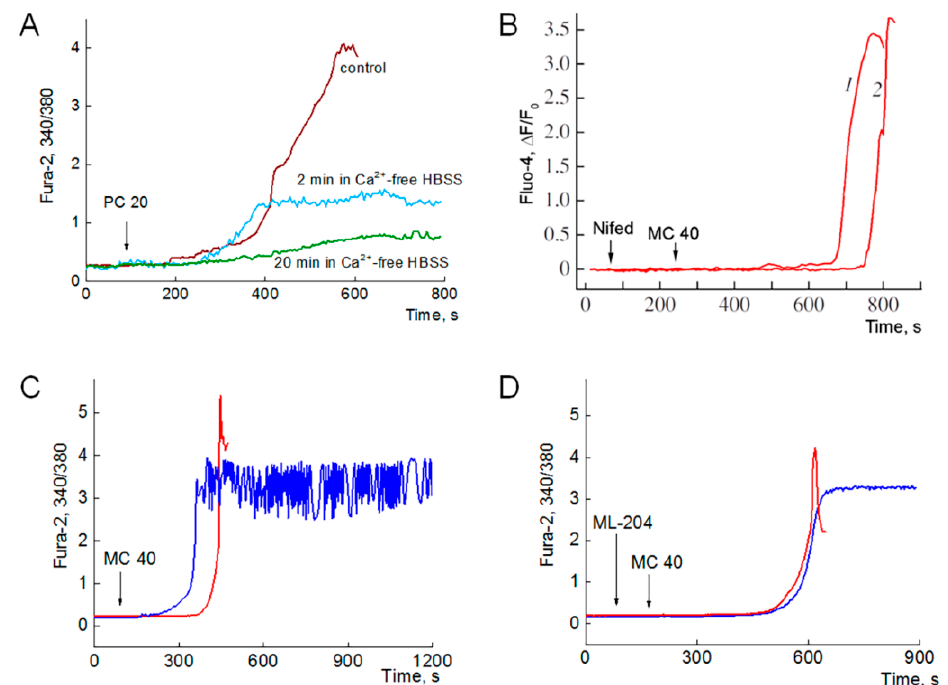
Figure 2. Ca 2 + -overload does not depend on external Ca 2 + influx. E ff ects of Ca 2 + -free medium and blockers of LCC and TRPC. ( A ). E ff ect of extracellular Ca 2 + on the increment of [Ca 2 + ] i (registered as Fura-2 340 / 380 ratio) induced by 20 µ M PC. Here, representative control and typical Ca 2 + traces are depicted. Cardiomyocytes were exposed to Ca 2 + -free medium for 2 min (red trace) and 20 min (green trace), while brown trace depicts control experiment with 1.3 mM Ca 2 + in extracellular medium. Hypercontracture and cell death were registered for control cells ( n = 6) and cells exposed to Ca 2 + -free medium (HBSS) for 2 min ( n = 8). Cells exposed to Ca 2+ -free medium for 20 min were viable after PC load ( n = 6). ( B ). L-type calcium channels do not significantly contribute to Ca 2+ overload. Average values of [Ca 2+ ] i (as Fluo-4 Δ F/F 0 ) are depicted in pane B for all cells ( n = 6 and 8). Preincubation of cardiomyocytes with 1 µ M nifedipine, a blocker of LCC, did not significantly a ff ected the values of such parameters as lag period, slope, and peak [Ca 2 + ] i characterizing Ca 2 + overload compared to control (traces 1 vs. 2). Ca 2 + overload, hypercontracture and CM death were induced by 40 µ M MC. This panel was adapted from [25] with permission. Viability score (VS), that is the ratio of viable to total cells in the plate, is indicated by corresponding values in panels ( C , D ). The e ff ect of TRPC blocker ML-204 (10 µ M) on Ca 2 + overload and Ca 2 + oscillations evoked by 40 µ M MC. Here, representative control ( C ) and typical Ca 2 + traces registered in presence of ML-204 ( D ) are depicted. In the control 40 µ M MC evoked Ca 2 + overload, hypercontracture and death within 300–350 s in 7 of 9 cells (representative red trace). In 2 cells MC triggered fast Ca 2 + oscillations lasting over 30 min (dark blue trace).Thus, for the control experiment, VS = 2 / 9 ( n = 9). Preincubation of CM with 10 µ M ML-204, a potent TRPC blocker, did not have any significant e ff ect on the values of lag period, slope and amplitude of Ca 2 + rise in 5 dying cells (compared to the parameters of control cells in panel C ). However, blockade of TRPC abrogated Ca 2 + oscillations in the rest of the 3 cells that remain viable within 30 min (dark blue representative trace. Thus, for this experiment VS = 3 / 8 ( n = 8). Graphs displayed at the panels are representative of 3 independent